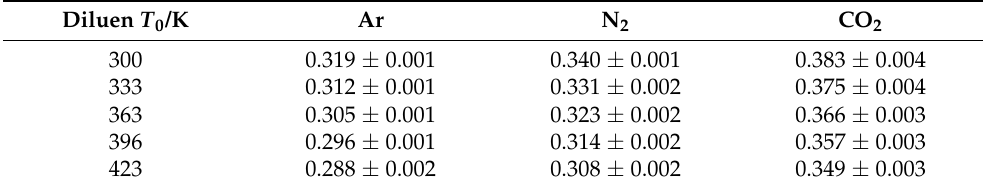
Table 3. Baric coefficients, - β , of calculated PVs, S s , for stoichiometric C 3 H 8 –air–diluent mixtures at p 0 = 1